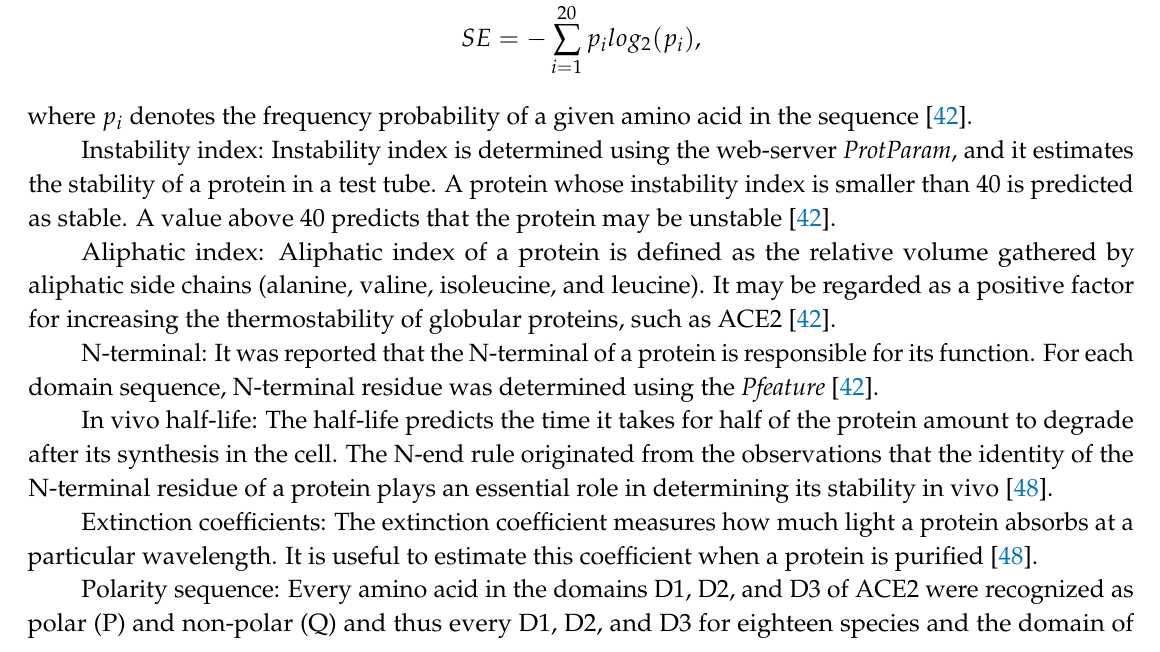
Algorithm: K-means algorithm is an iterative algorithm that tries to form equivalence classes from the feature vectors into K (pre-defined) clusters where each data point belongs to only one cluster